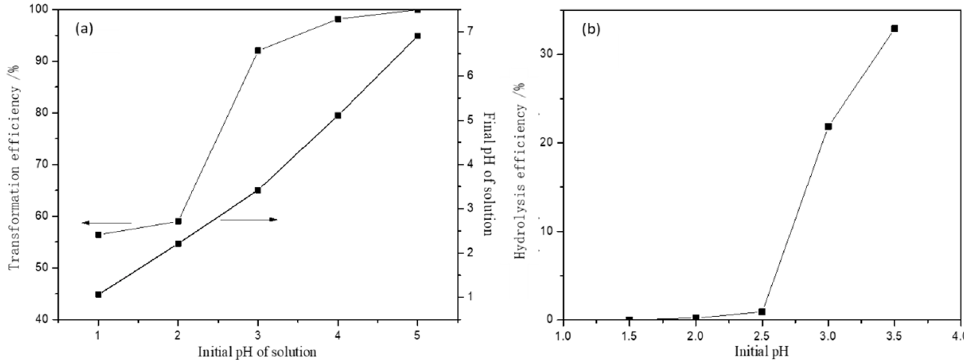
Figure 2. Effect of initial pH on the Fe( Ⅲ ) transformation efficiency in the presence of HAP ( a ) and on the hydrolysis efficiency of Fe( Ⅲ ) in the solution ( b ).